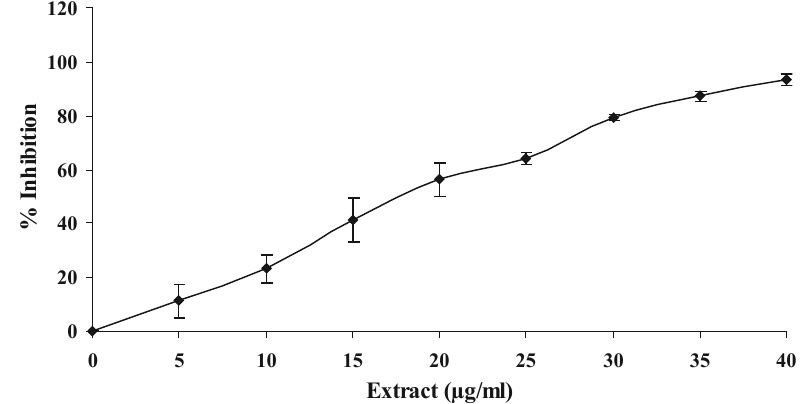
Figure 4 - Effect of substrate concentration on inhibition of NN-XIa-PLA by 2 aqueous stem bark extract of M. indica . The reaction mixture contained NN- XIa-PLA enzyme in 0.05 M Tri-HCl buffer pH 7.5, 500 mM CaCl , inhibitors, and 2 2 increasing concentrations of substrate (0-120 nM). The reaction was carried out in the absence (rhombus) and presence of IC concentration of extract (open square) 50 with increasing concentration of substrate. The fi gure inset represents the percent of inhibition in the presence of IC concentration. Data represents ± S.E.M for n=3. 50